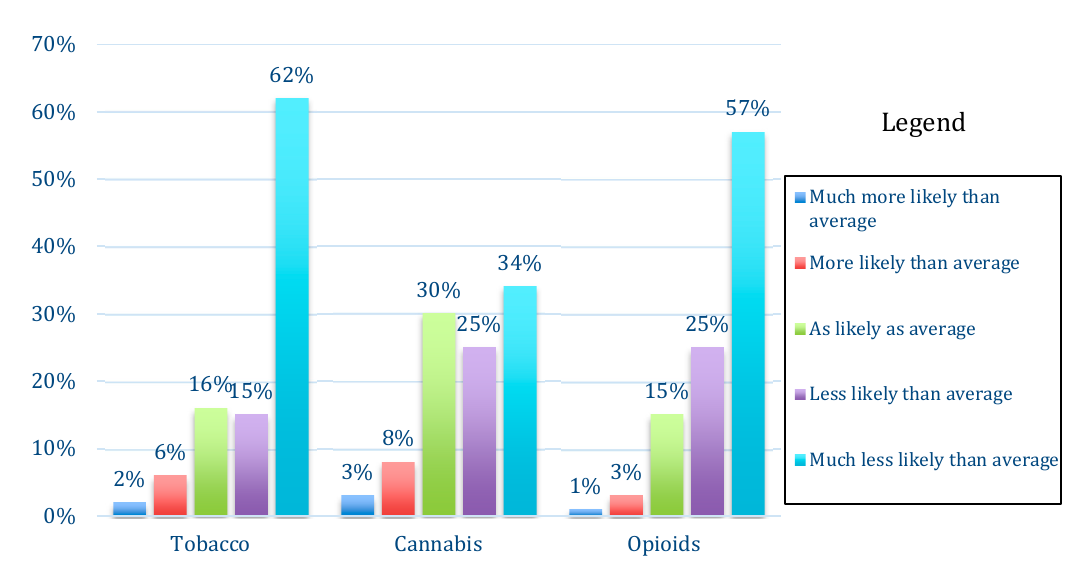
Figure 1. Distribution of parental assessment of likelihood of child’s risk of tobacco, cannabis, and opioid use initiation before age 18 ( n = 400). Participants with missing data and participants with children who had already initiated smoking, cannabis, or opioid use were excluded from optimism analyses.